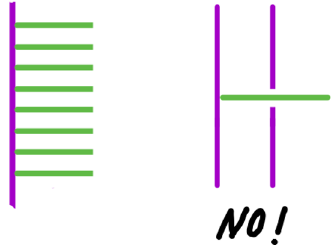
Figure 4 . Bit-threads emitted from a horizon. The maximum area-density bit-threads is 1 / 4 G . Bit-threads may not cross a horizon.